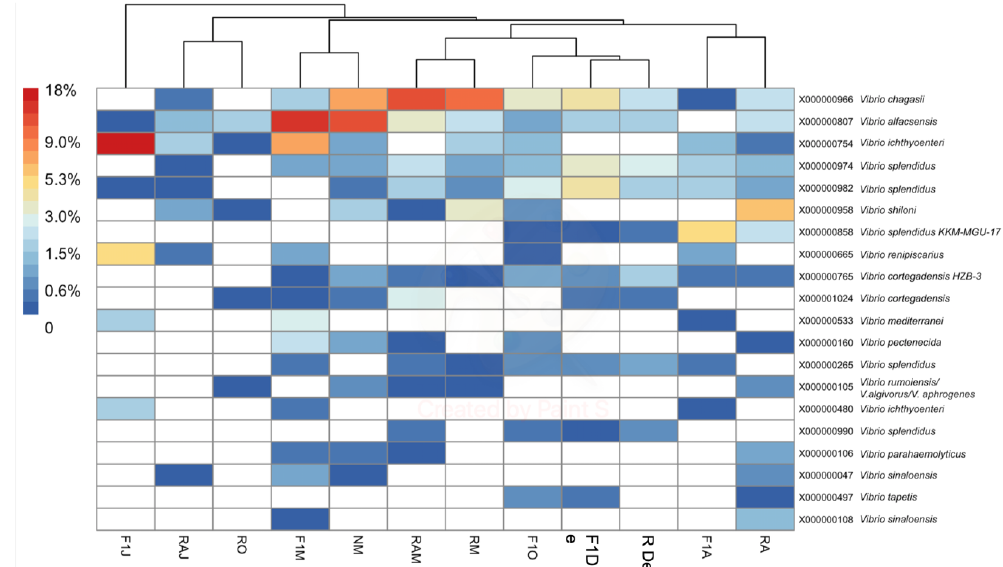
Figure 4. Heatmap of the percent abundance of the 20 most abundant minimum entry decomposition (MED) nodes within the genus Vibrio . Hierarchical clustering of samples is based on Bray–Curtis differences among samples calculated using all Vibrio nodes (n = 109). F1M, F1J, F1O, F1De, and F1A: first-generation juvenile specimens born in the center (F1) sampled in March, June, October and December 2014, and April 2015, respectively. RM, RO, RDe, and RA: younger reproductive adults sampled in March, October, and December 2014 and April 2015, respectively. RAM, RAJ: older reproductive adults sampled in March and June 2014, respectively. NM: Nursery larvae sampled in March 2014.